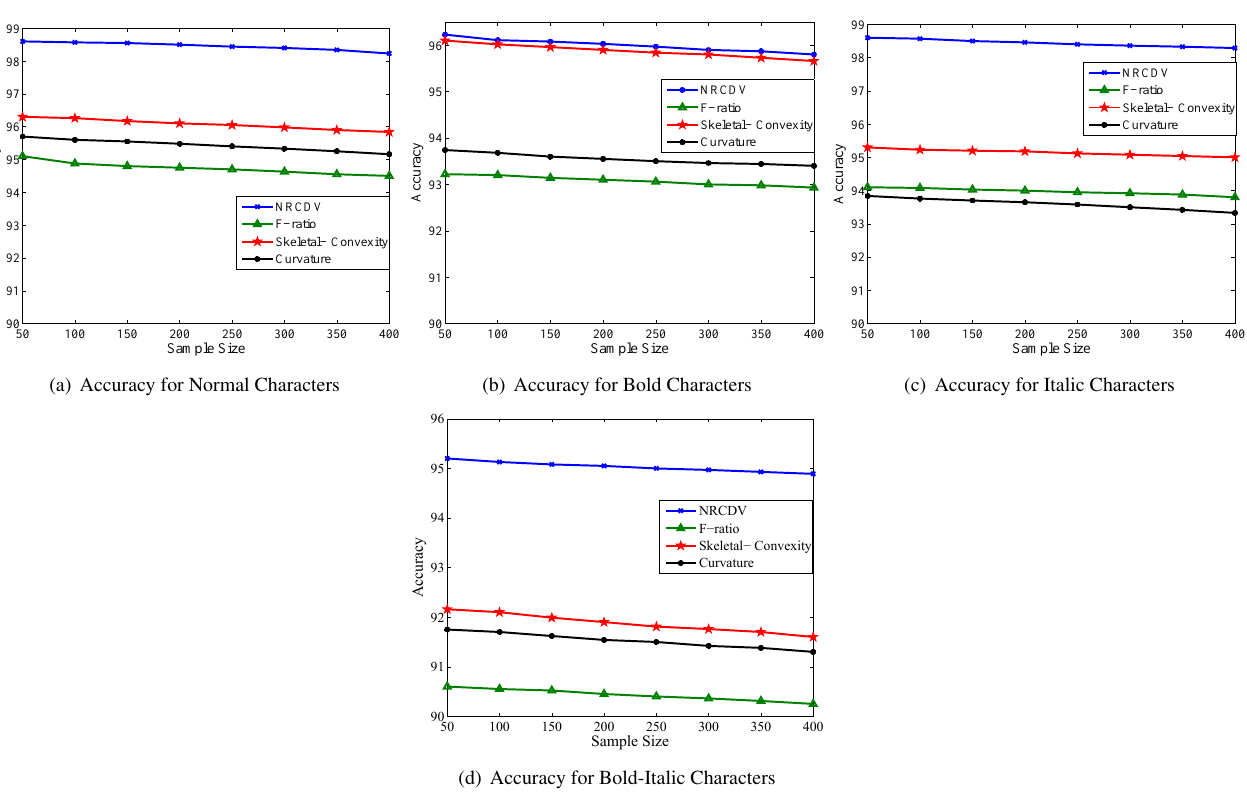
Figure 13. Accuracy Comparison with other competent